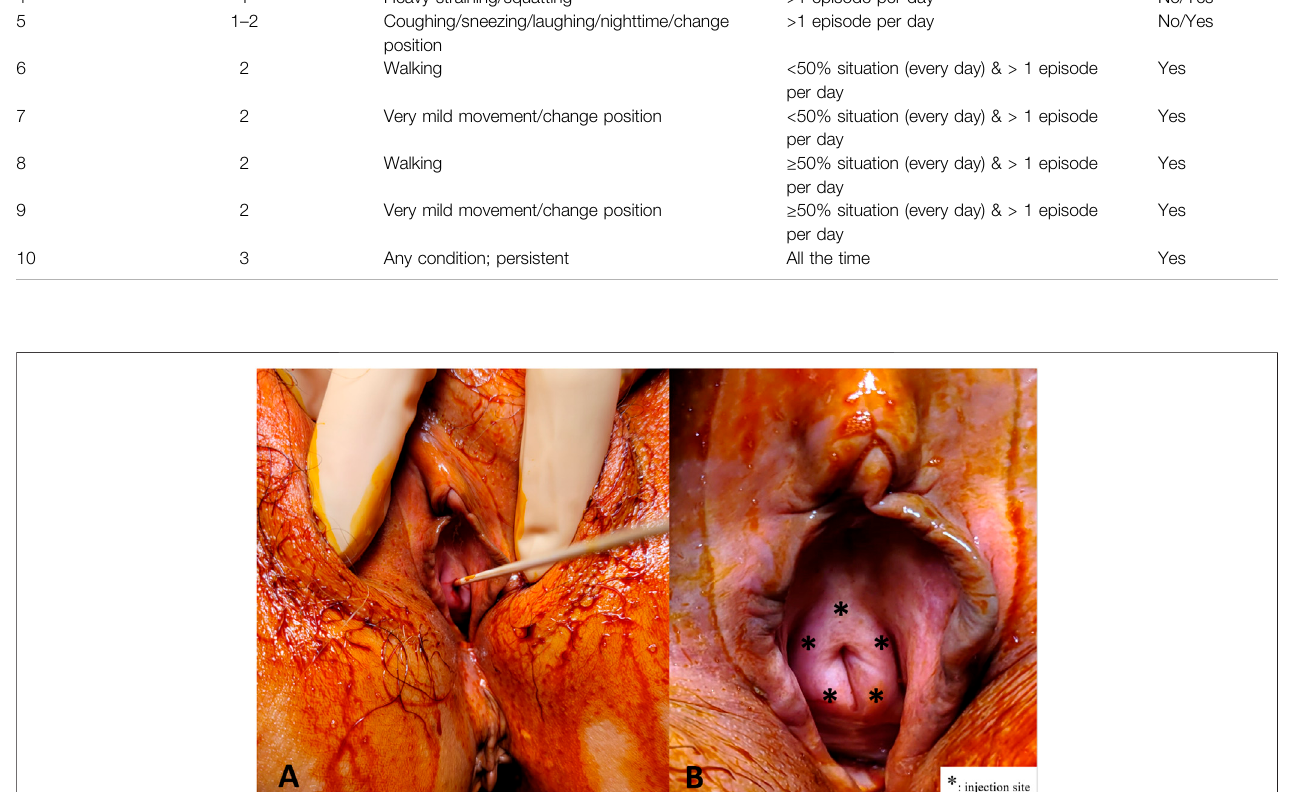
Frontiers in Pharmacology |